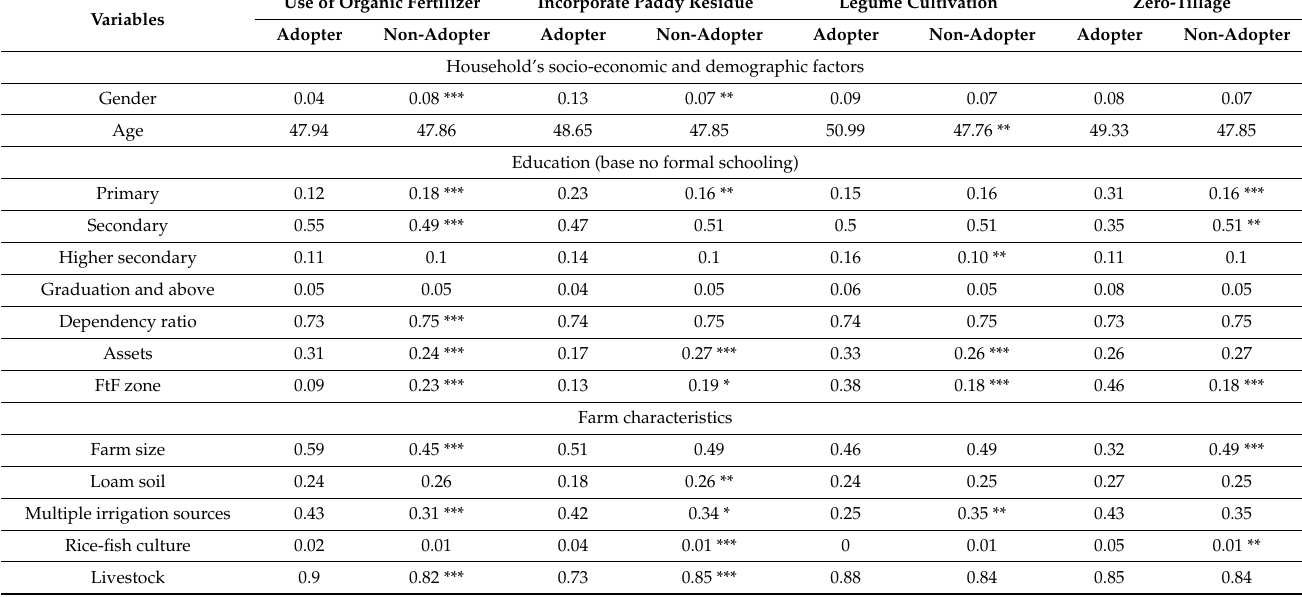
Figure 2. Number of sustainable soil management practices adopted by the adopter farmers. Table 3. Summary statistics of the variables used in explaining adoption of sustainable soil management